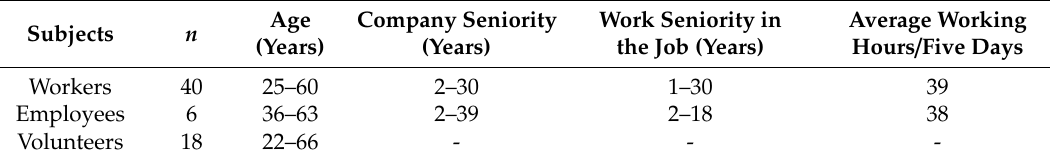
Table 1. Characteristics of the